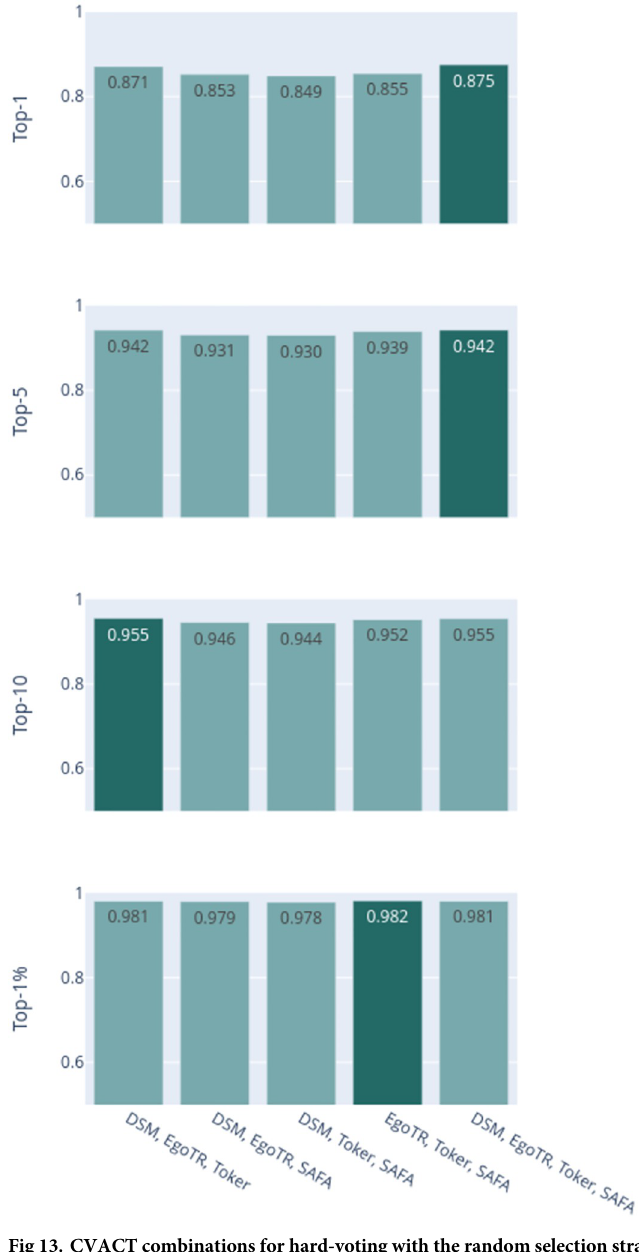
Fig 13. CVACT combinations for hard-voting with the random selection strategy. point. The brown line(naive history with prior) and the green line (plain naive history) in the figure represent the same number of steps into the trip, though the brown line shows more accurate predictions due to factoring in the weak prior.